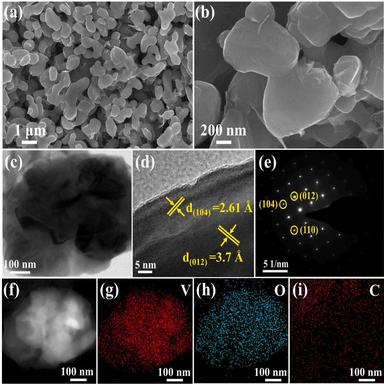
(a, b) SEM images of B–V2O3@C. (c) TEM image of B–V2O3@C, (d) HR-TEM image, (e) SEAD pattern, (f) HADDF and (g–i) mapping images of B–V2O3@C.